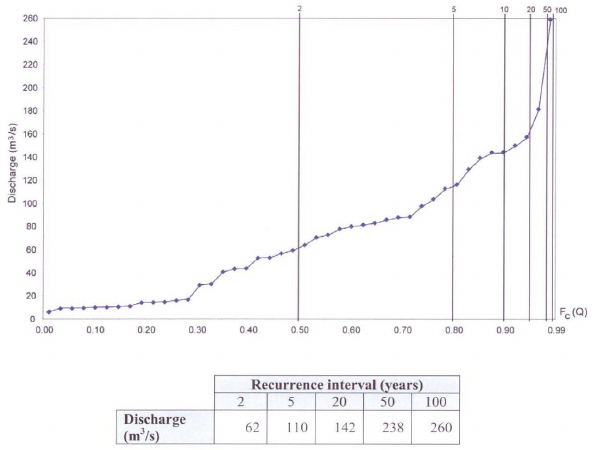
Fig. 4. Adjustment of maximum annual flood for the R´ıo Chili using a Gumbel distribution (after Martelli, 2011). The figure allows us to determine the maximum annual flood discharge and recurrence intervals (2, 5, 20, 50 and 100yr) in the R´ıo Chili.